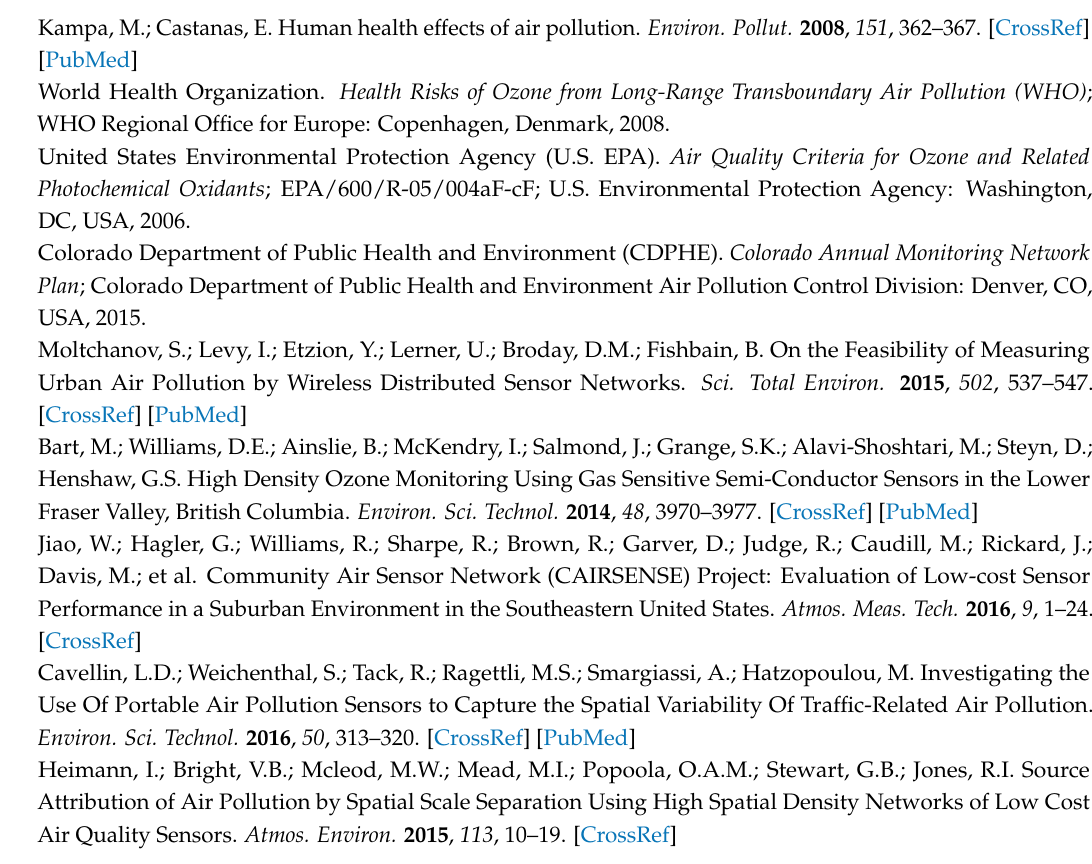
Table S1: Model Fit Testing Results for UPod SBC1, Figure S1: Residuals for SBC1 collocation data calibrated using Equation (4), Figure S2: Normalized histograms showing the parameter space of ozone, temperature, and humidity during the various data collection periods (calibration generation, data validation, and deployment) for both SBC and Campus UPods. The SBC calibration period encompassed the parameter space of the other periods well, while the campus deployment measured slightly higher ozone, temperature, and relative humidity than the calibration generation period. We can be more confident in our SBC calibration models than our campus calibration models because we are not extrapolating as much into different environments than we measured during the calibration generation period, Figure S3: Scatterplots of R s /R o vs. temperature, humidity, and ozone for each SBC UPod during the data validation period. The scatterplots demonstrate the correlation between the various terms in the calibration model to the sensor response. R 2 values indicate correlation between R s /R o and the variable plotted on the x-axis. The sensor signals were more correlated with ozone concentration than with either temperature or humidity for all UPods, Table S2: P-Values for F Test that Calibration Model Coefficient Estimates are Zero at the 5% Significance Level, Figure S4: Time series of ozone measurements by SBC1 (a), SBC2 (b), SBC3 (c), and SBC4 (d) during validation data period with UPod data (red) and reference data (blue) shown in each